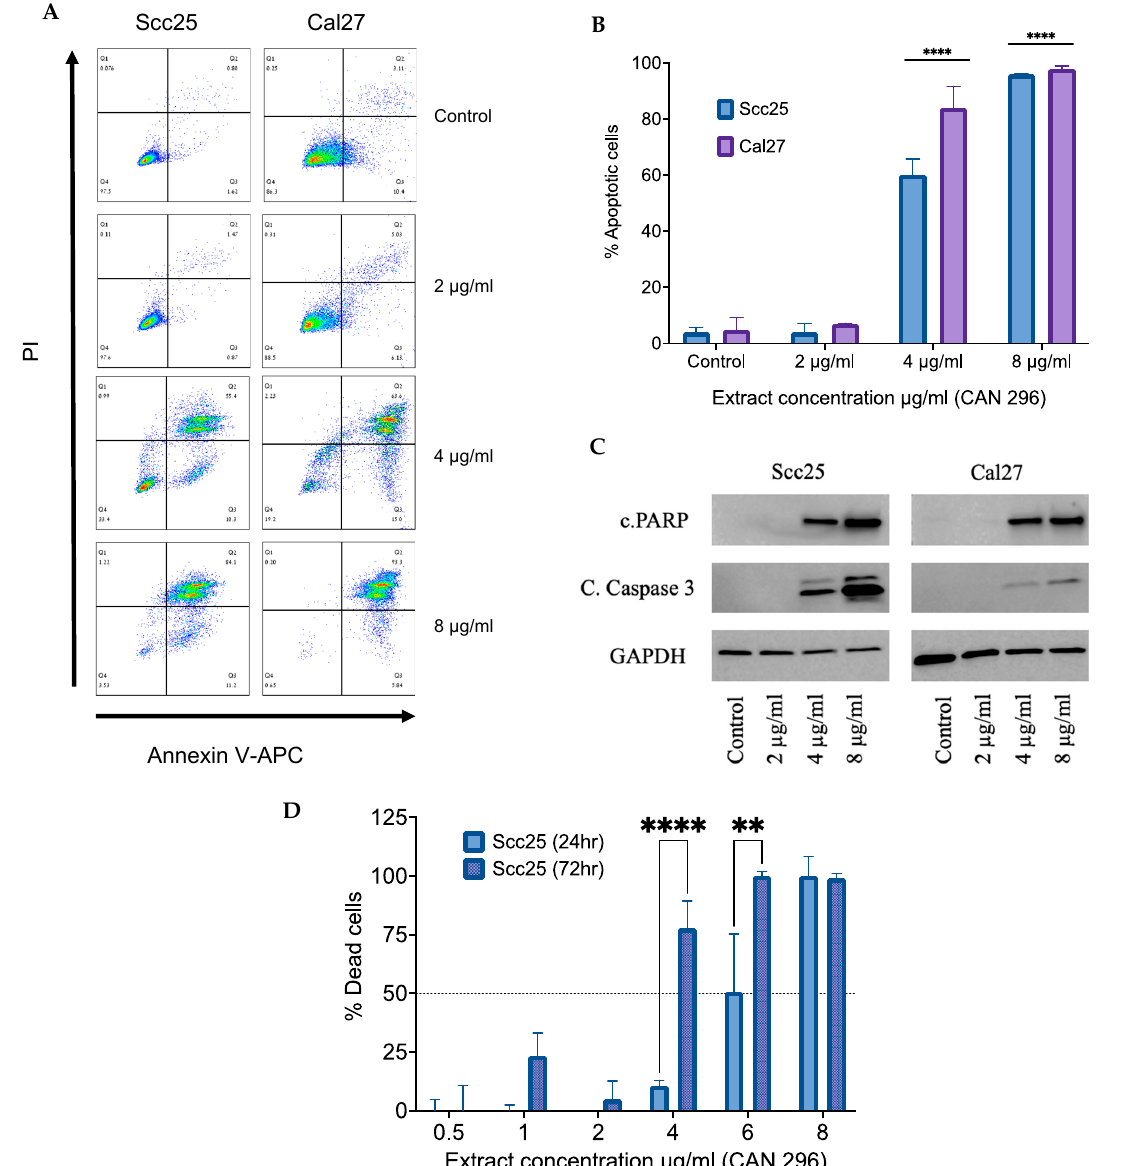
Figure 3. Apoptotic effect of Cannabis extracts on HNSCC. Extract CAN296 (2, 4, 8 μ g/mL) was applied on Scc25 or Cal27 cells for 12 h, with DMSO as the control. ( A ) Apoptosis (early and late) was assessed by APC Annexin-V/PI staining with flow cytometry. ( B ) The percent of apoptotic cells was calculated as % of positive Annexin-V APC cells out of the total cells counted (events = 10,000) and presented as mean ± SE (n = 3). Statistically analyzed with two-way ANOVA followed by Tukey’s multiple comparisons test, and asterisks indicate significant differences compared to the control (**** p < 0.0001;). ( C ) Cells were lysed and resolved on 15% SDS-PAGE, followed by western blotting with anti-Cleaved Caspase 3, c.PARP and GAPDH as the loading control. ( D ) Scc25 cells were treated with 0.5–8 μ g/mL CAN296 extract for either 24 or 72 h, and cell proliferation was assessed according to WST-1 assay. The percent of vital cells relative to DMSO (control) is presented as mean ± SE (n = 3). Asterisks indicate statistical significance between 24 h and 72 h treatment (** p < 0.0005, **** p < 0.0001; two-way ANOVA with Sidak’s post-hoc multiple comparison test).